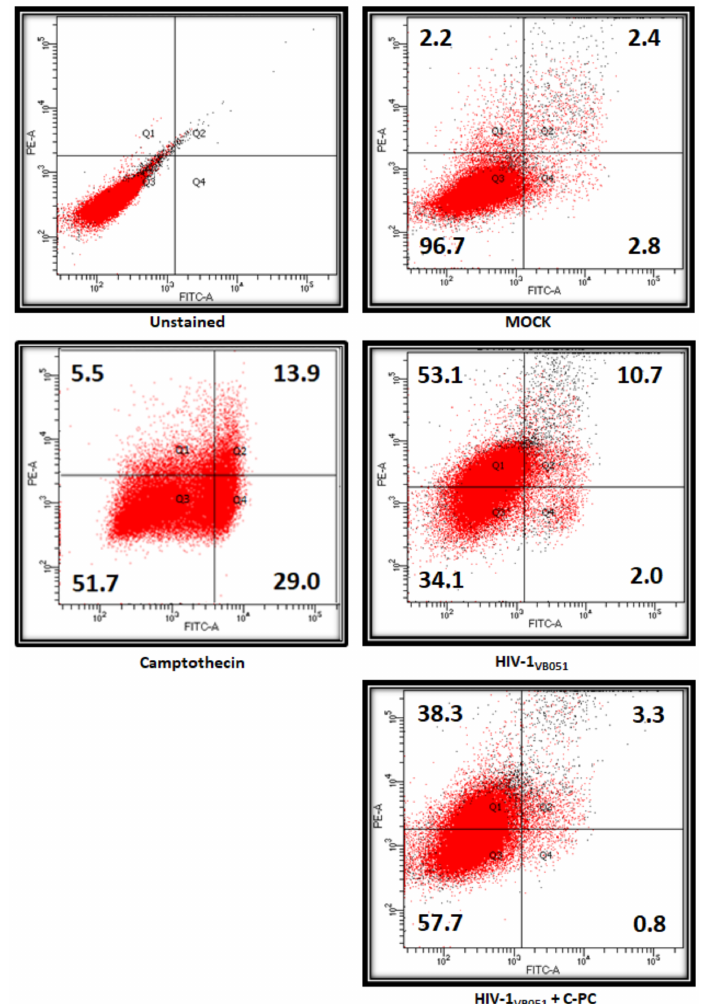
Figure 8. Annexin V-FITC Apoptosis staining. Representative flow cytometry dot plots illustrate annexin-FITC acquired on FL-1H (X-axis) versus PI staining acquired on FL-2H (Y-axis). HIV-1 VB051 - infected TZM-bl cells were treated with C-PC (0.1740 mg/mL) for 24 h and cell death was assessed using annexin V-fluorescein isothiocyanate (FITC)/propidium iodide (PI) staining represented as Q1: Necrotic cells, Q2: Late apoptotic cells, Q3: Live cells and Q4: Early apoptotic cells. TZM-bl cells treated for 6 h with Camptothecin (15 µ m) was taken as a positive control in the